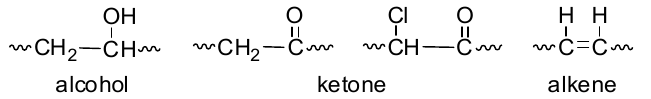
Figure 2. Alcohol, ketone, and alkene fragments formed by photo-oxidation of poly(vinyl chloride) (PVC).